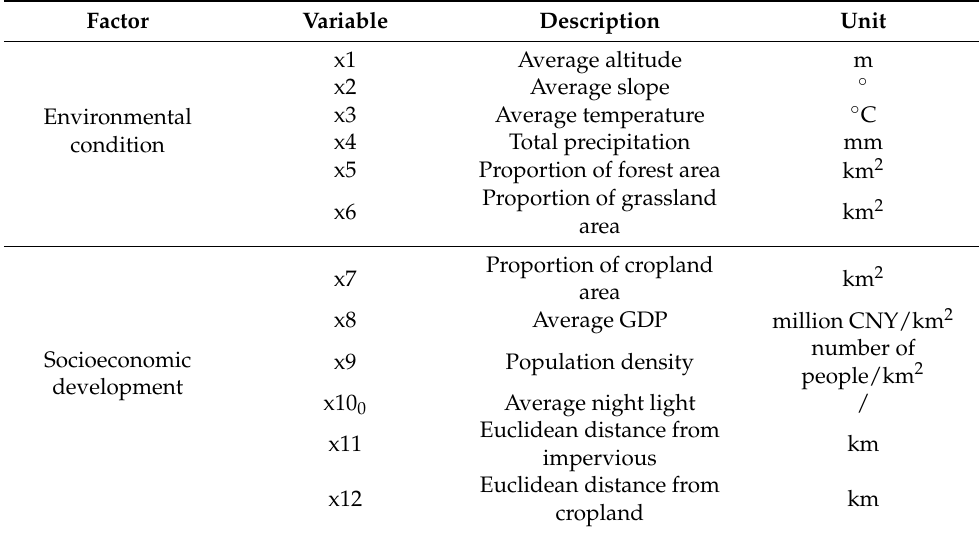
Table 2. Factors and explanatory variables of driving factors for ECA evolution. Factor Variable Description Unit